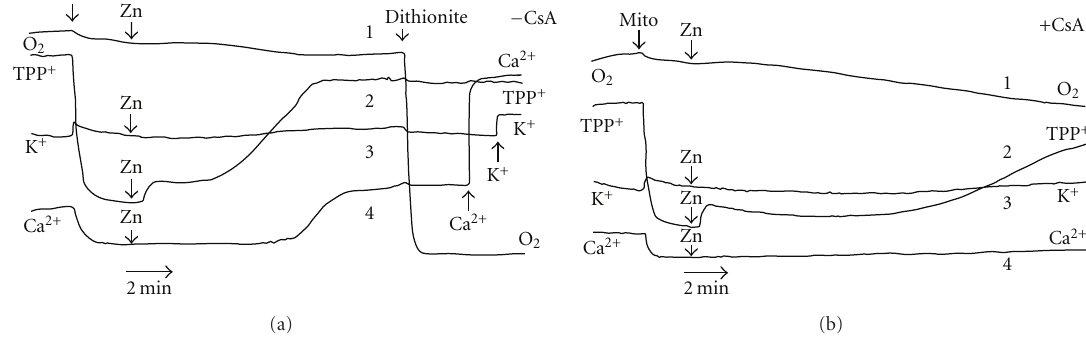
Figure 5: Simultaneous recordings of four mitochondrial parameters (respiration, ΔΨ mito, K + , and Ca 2+ fluxes) with the help of O 2 , TPP + , K + , and Ca 2+ -selective electrodes after treatment of isolated RLM with Zn 2+ in the absence (a) or presence of CsA (b). Mitochondria (1mg protein/mL) were incubated at room temperature in a medium containing 120 mM NaCl, 2 mM NaH 2 PO 4 , 10 mM HEPES (pH 7.4), 5mM Glu, and 5mM Mal. The additions of Zn 2+ (5 µ M), K + (100 µ M), Ca 2+ (200 µ M), and dithionite are indicated by arrows. [CsA] was 1 µ M. 20 µ M of Ca 2+ were present in the assay medium from the beginning of experiment. Downward deflection indicates decrease in [O 2 ], [TPP + ], ], and [Ca 2+ ] in the medium. The results are representative for a series of two independent experiments. [K + free free